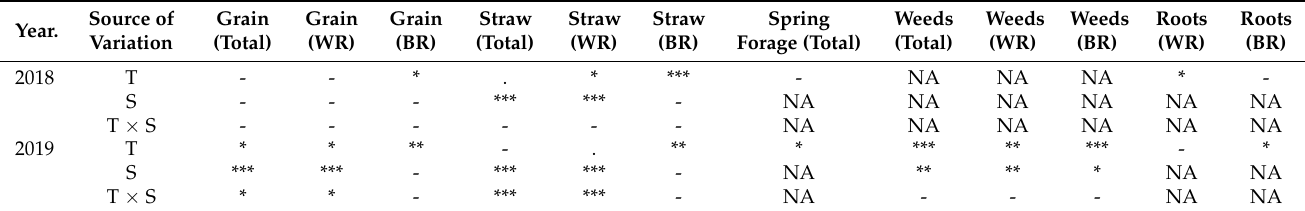
Table 2. Analysis of variance (ANOVA) test results for the effects of termination (T) and suppres- sion (S) treatments on grain, straw, and spring forage yield, weed biomass, and root biomass between- and within-rows of planted intermediate wheatgrass (IWG). Root sampling depth from 0–60 cm. Spring forage yield was only measured in mowed suppression sub plots while roots were only measured in the control suppression sub plots. Weeds were not measured in